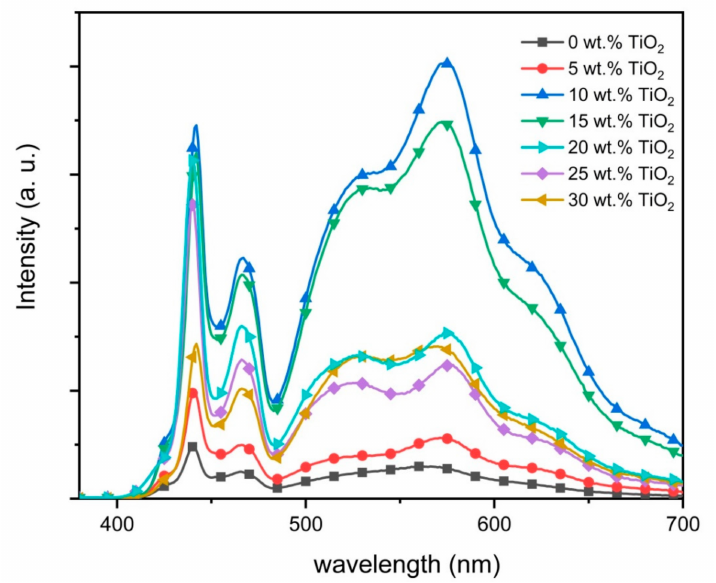
Figure 6. Emission spectra of PFO / 0.5 wt.% F8BT / 0.3 wt.% MEH-PPV / TiO 2 nanocomposite films with di ff erent wt.% of TiO 2